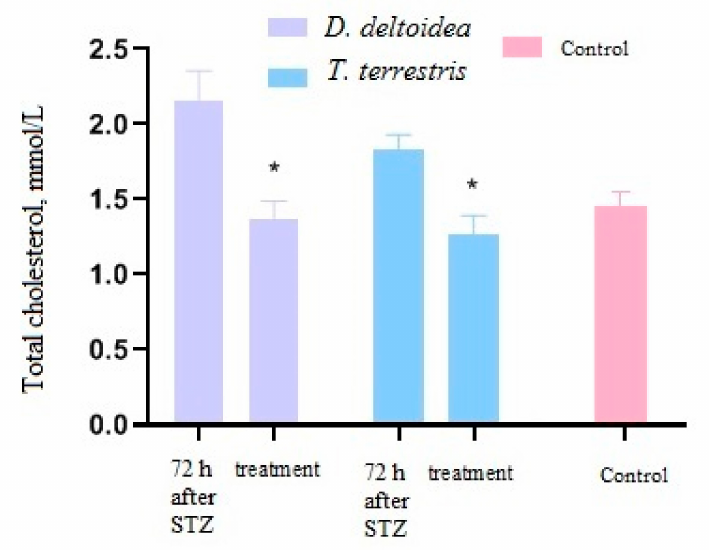
Figure 8. Change of total cholesterol level in blood after treatment with phytopreparations. * Significantly different from the period after administration of STZ. Control—intact